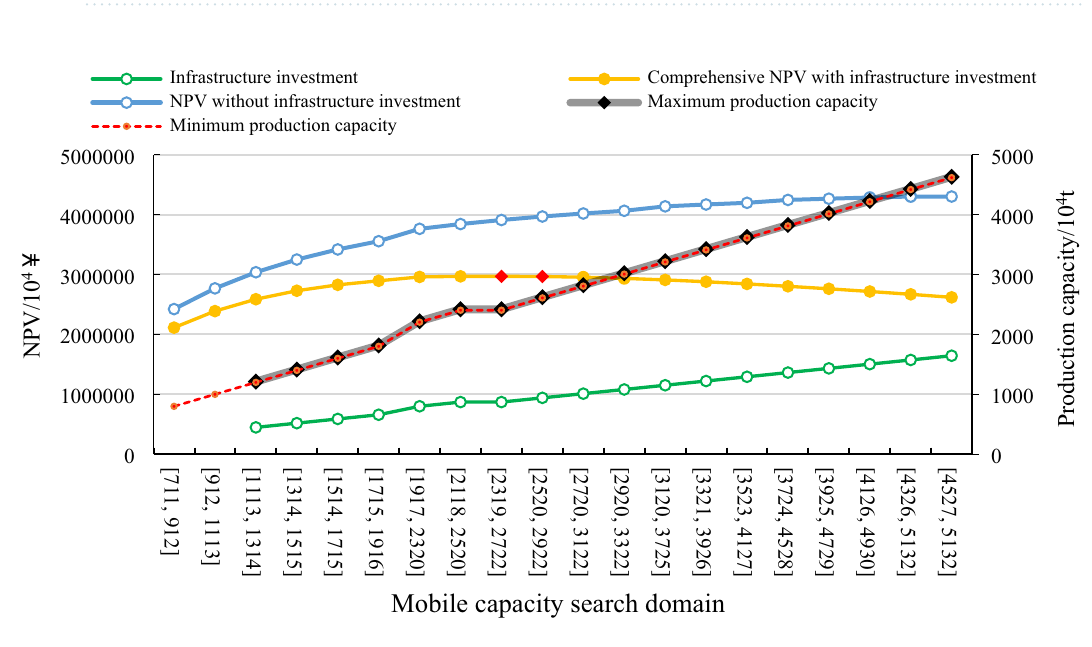
Figure 8. Results of optimal schemes in different capacity search